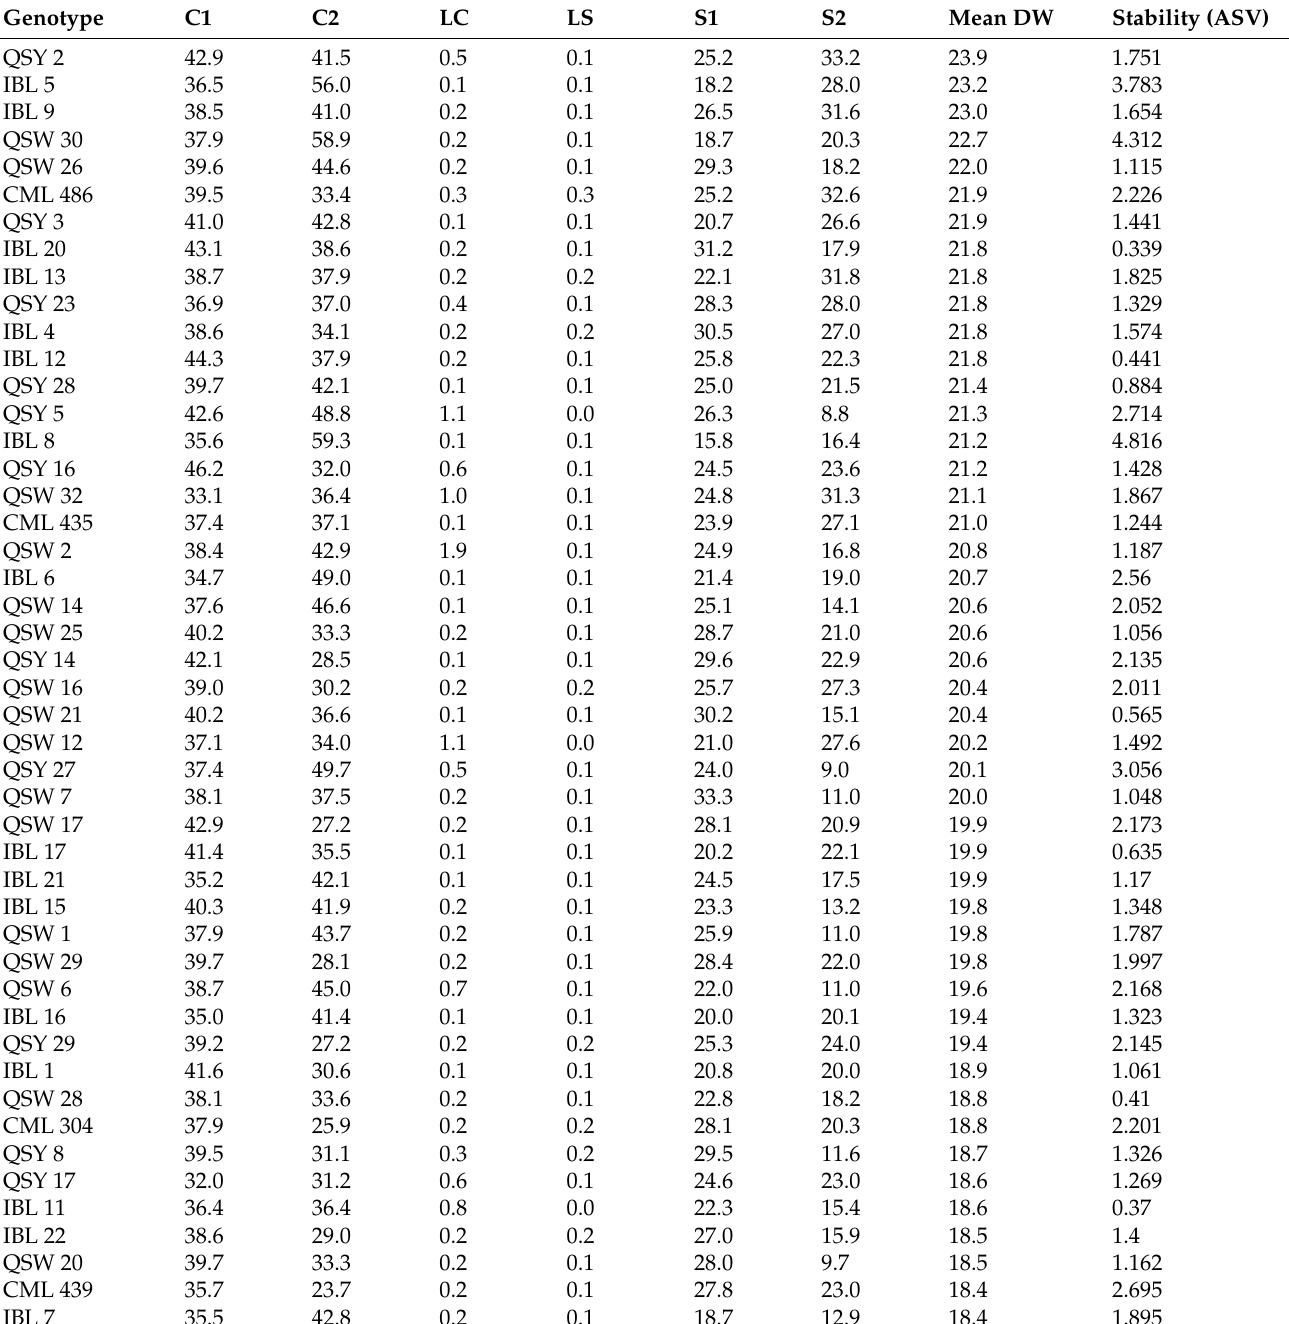
Table A1. Mean yield all the 75 QPM maize inbred lines tested across the six